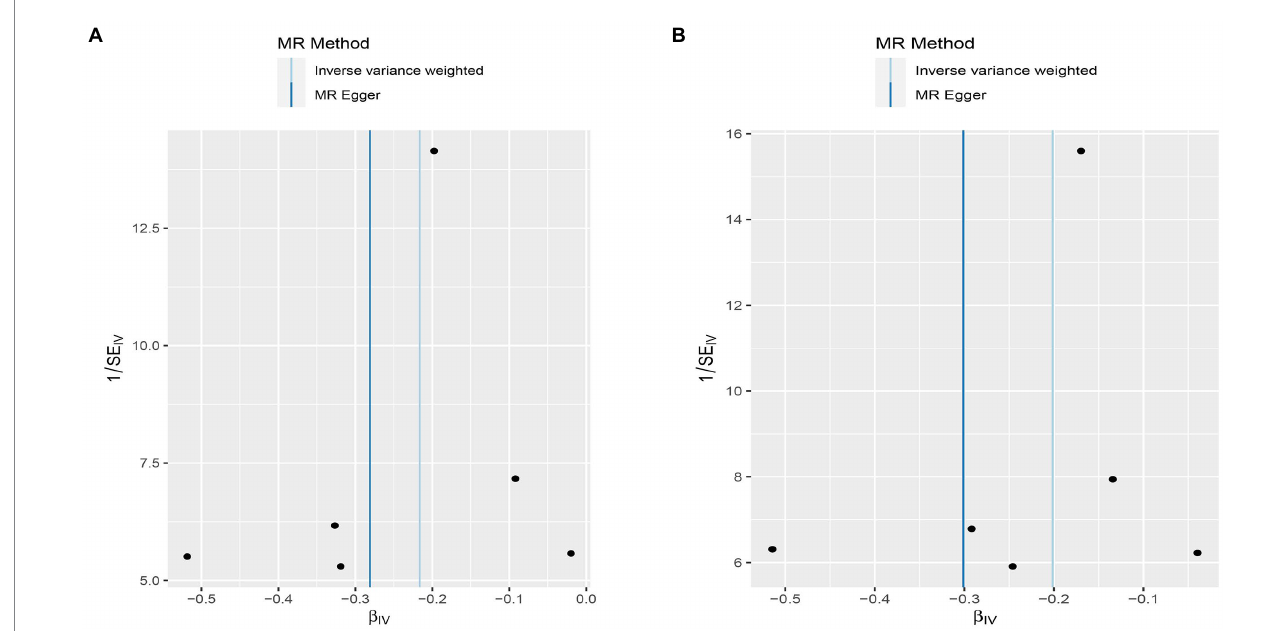
FIGURE 10 Funnel plot MR estimates of genetic risk of OPG on AMI and CHD after removing rs1385492. The funnel plot of genetic effect of OPG relative to its effect on AMI (A) and CHD (B) , and the distribution of corresponding points reflected the heterogeneity.